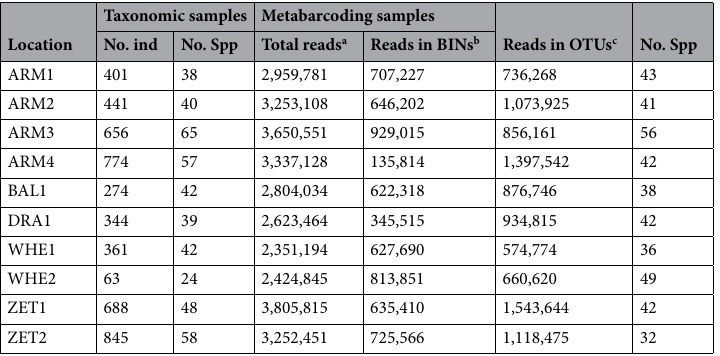
Table 1. Number of individuals and species of ants, springtails and termites (with BINs; traditional samples) and number of reads, reads in BINs, reads in OTUs and species (metabarcoding samples) recorded in samples grouped by location. a Total no. of reads uploaded in mBRAVE. b Matched BINs, mostly arthropods. c Arthropods and non-arthropods, the later including vertebrates, invertebrates and plants.